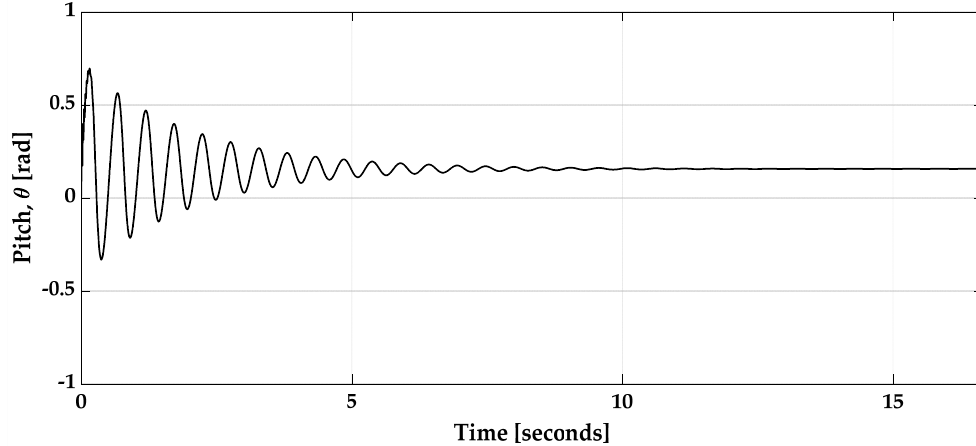
Figure 37. Pitch angle ( θ ) versus time plot for longitudinal stability case.